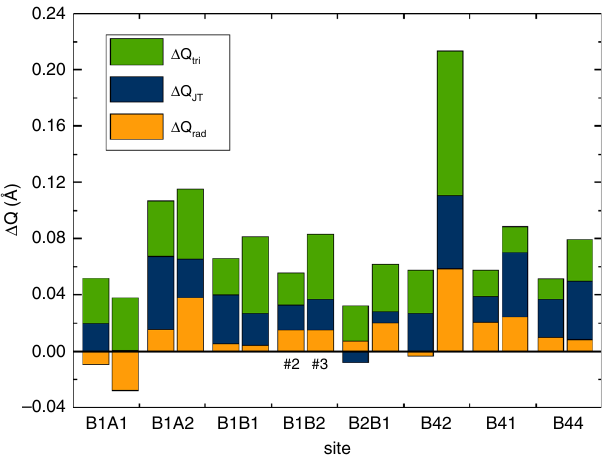
Fig. 3 Changes of Fe 2 + site distortion amplitudes on hole doping of magnetite. Changes in radial ( − Δ Q rad ), Jahn – Teller ( Δ Q JT ) and trimeron ( Δ Q tri ) modes for the eight distinct Fe 2 + sites within the charge-ordered magnetite superstructure between the undoped sample #1 and samples #2 (left hand column for each site) or #3 (right hand columns) are shown. Negative values are shown below the horizontal axis.